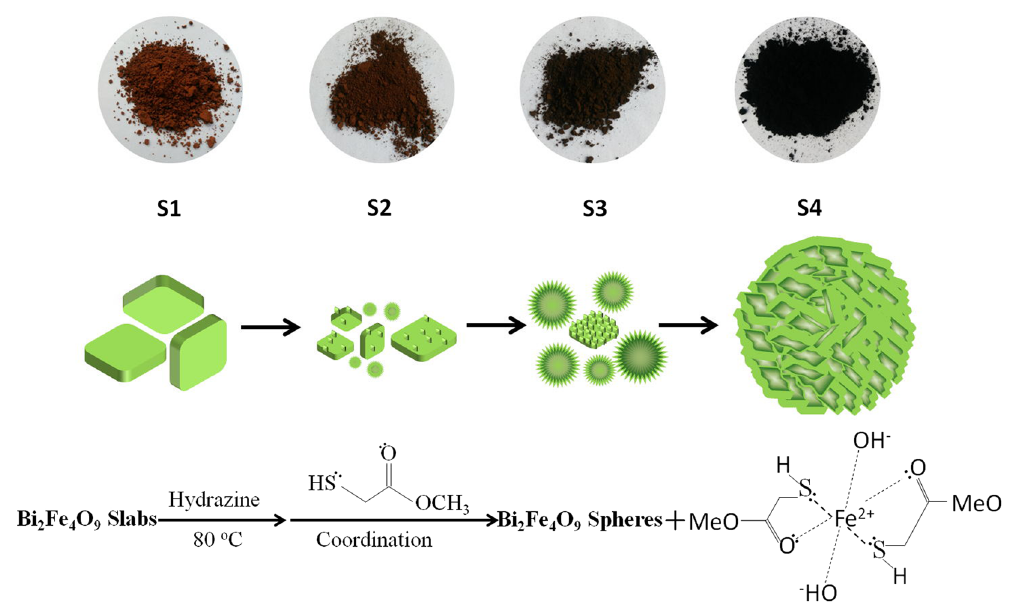
Figure 4. Schematic illustration of forming process of three-dimensional porous Bi 2 Fe 4 O 9